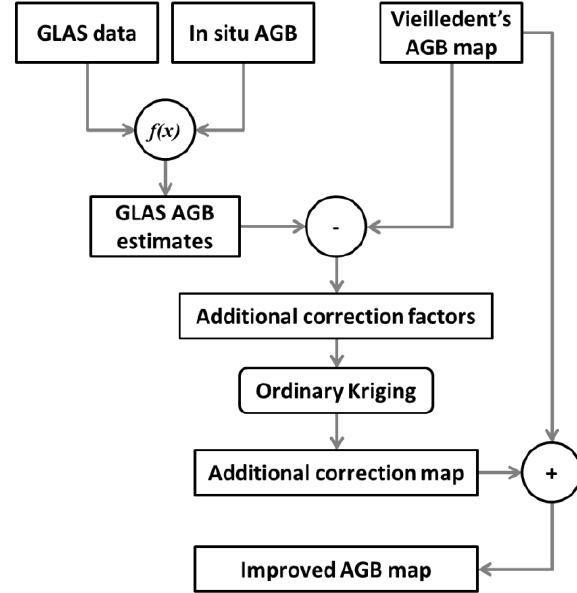
Figure 3. Procedure for improving Vieilledent’s AGB map.